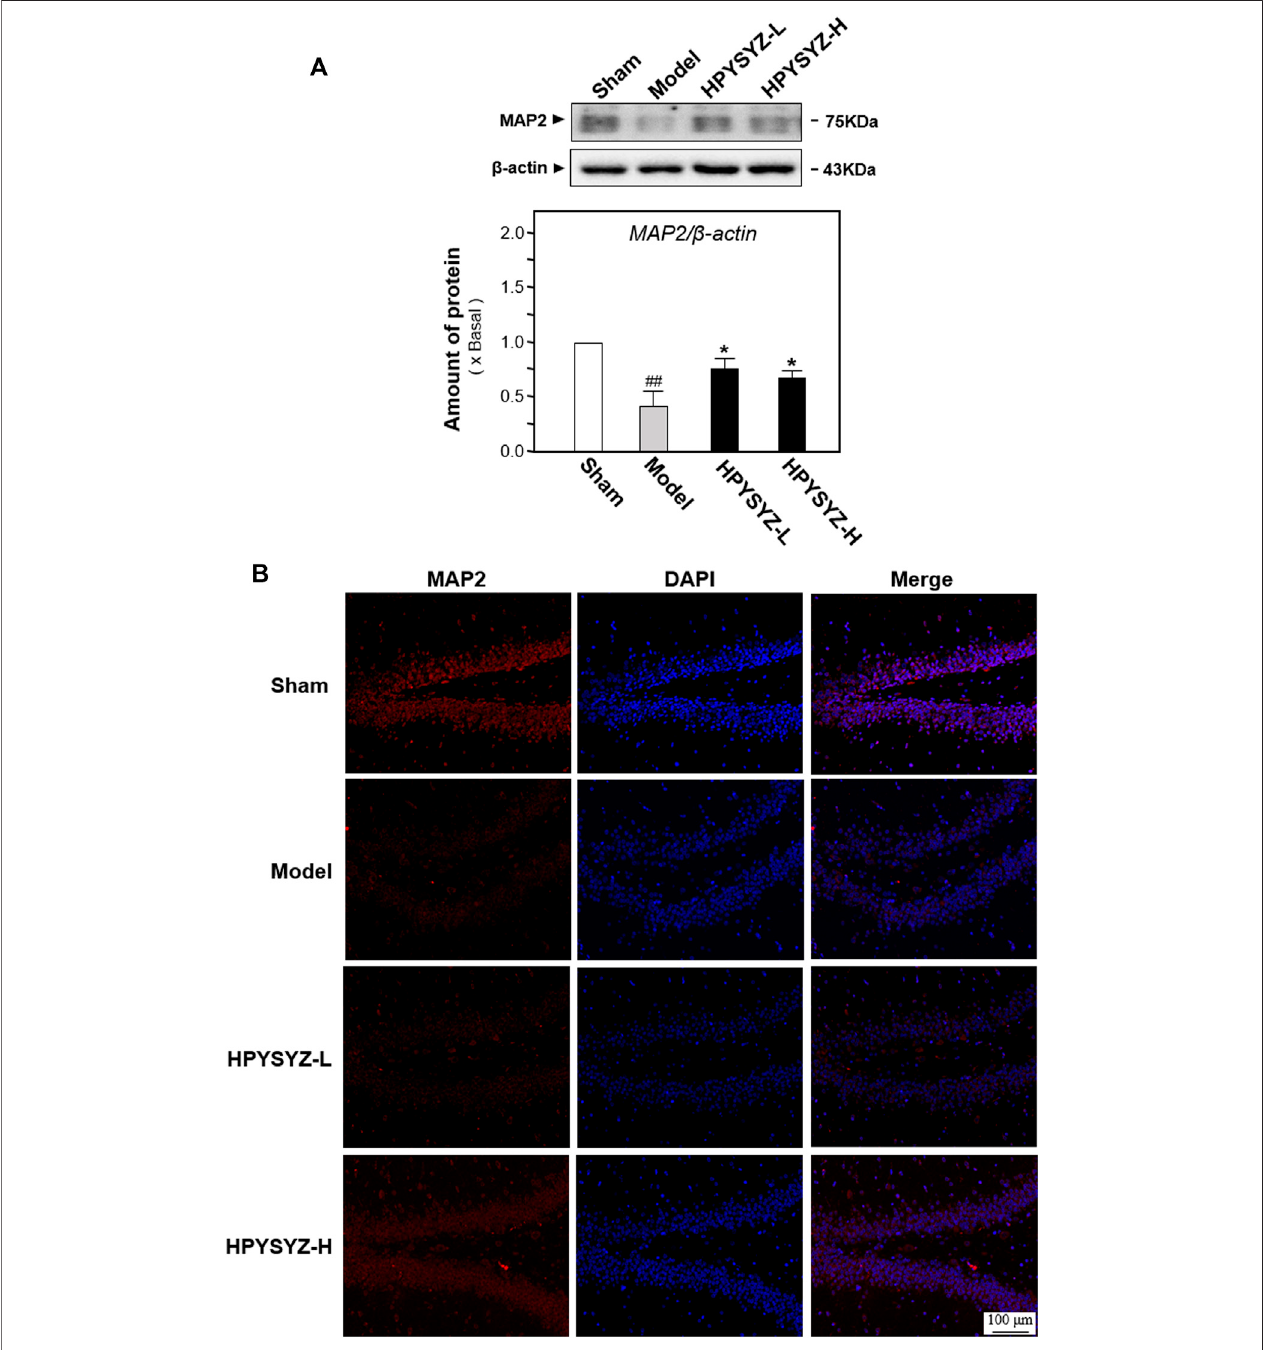
FIGURE 4 | Ethyl acetate extracts of succinum regulated the expression of neuronal marker MAP2 in the hippocampus on carotid artery ligation rats. (A) Expressions of neuronal cell marker MAP2 were determined in the hippocampus of carotid artery ligation rats by Western blotting analysis. Values are expressed as mean±SEM( n =5).Comparisonsbetweengroupswerecarriedoutbyaone-wayANOVAfollowedbya posthoc Bonferronitest. ## p < 0.01(comparedwiththenormal controlgroup),* p < 0.05,and** p < 0.01(comparedwiththecarotidarteryligationmodelgroup). (B) ExpressionsofneuronalcellmarkerMAP2weredetermined in the hippocampus of carotid artery ligation rats by immunohistochemistry analysis. The low dose treatment of ethyl acetate extracts of succinum (HPYSYZ-L) was set as 0.21 g/kg/d, and the high dose treatment (HPYSYZ-H) was set as 0.42 g/kg/d ( n = 3). expressions of GSK3 β / β -catenin pathway-related kinases As shown in Figures 5A,B , the ratio of p-GSK3 β to GSK3 β was including GSK3 β , p-GSK3 β , β -catenin, and p- β -catenin were decreased in the hippocampus of carotid artery ligation rats determined in the hippocampus of carotid artery ligation rats. compared with the sham group, while the ratio of p- β -catenin